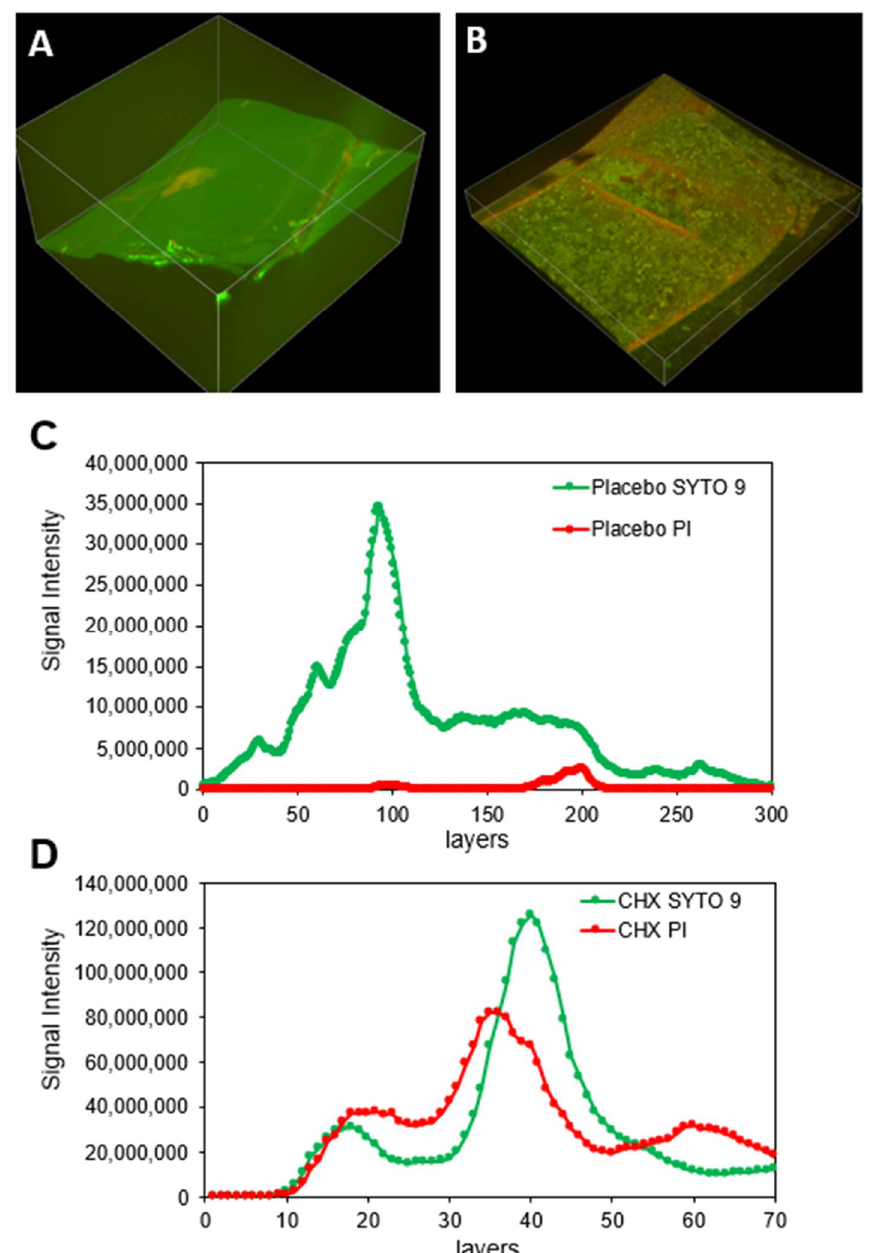
Figure 5. ( A , B ) SYTO 9/PI staining of S. aureus subsp. aureus ATCC 25923 biofilm formed on SRV- placebo ( A ) and SRV-CHX ( B )-coated SNS segments at day 7. ( C , D ) Quantification of the staining of stents coated with either SRV-placebo ( C ) or SRV-CHX ( D ).